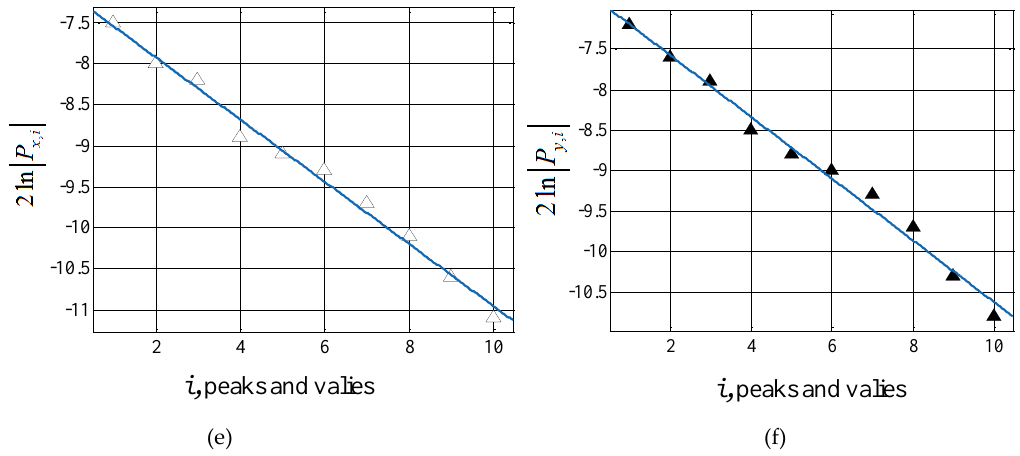
Figure 5. Identification of damping ratio in Z11 . ( a ) Measured κ x ,1 , ( b ) Measured κ y ,1 , ( c ) F − 1 ( Q x ,1 Q ∗ ) , ( d ) F − 1 ( Q y ,1 Q ∗ y ,1 , ( e ) Logarithmic decrement to identify damping, ( f ) Logarithmic decrement to identify damping in Y direction.